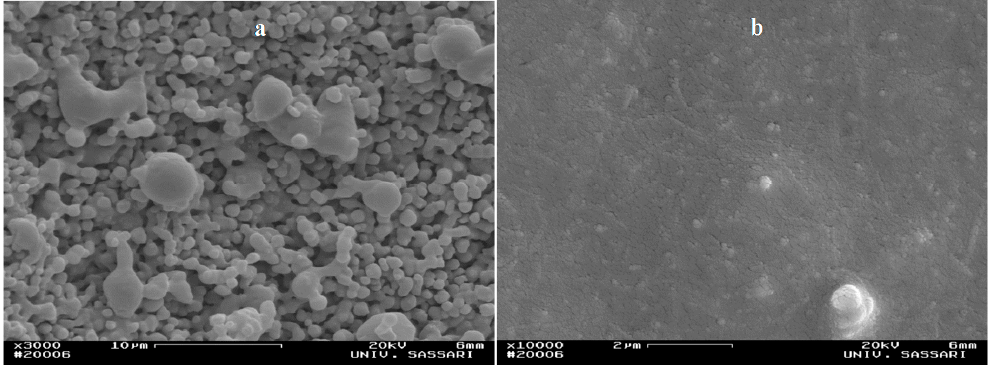
Figure 4. Scanning electron microscopy (SEM) images of ES-NH heated at 1200 °C.